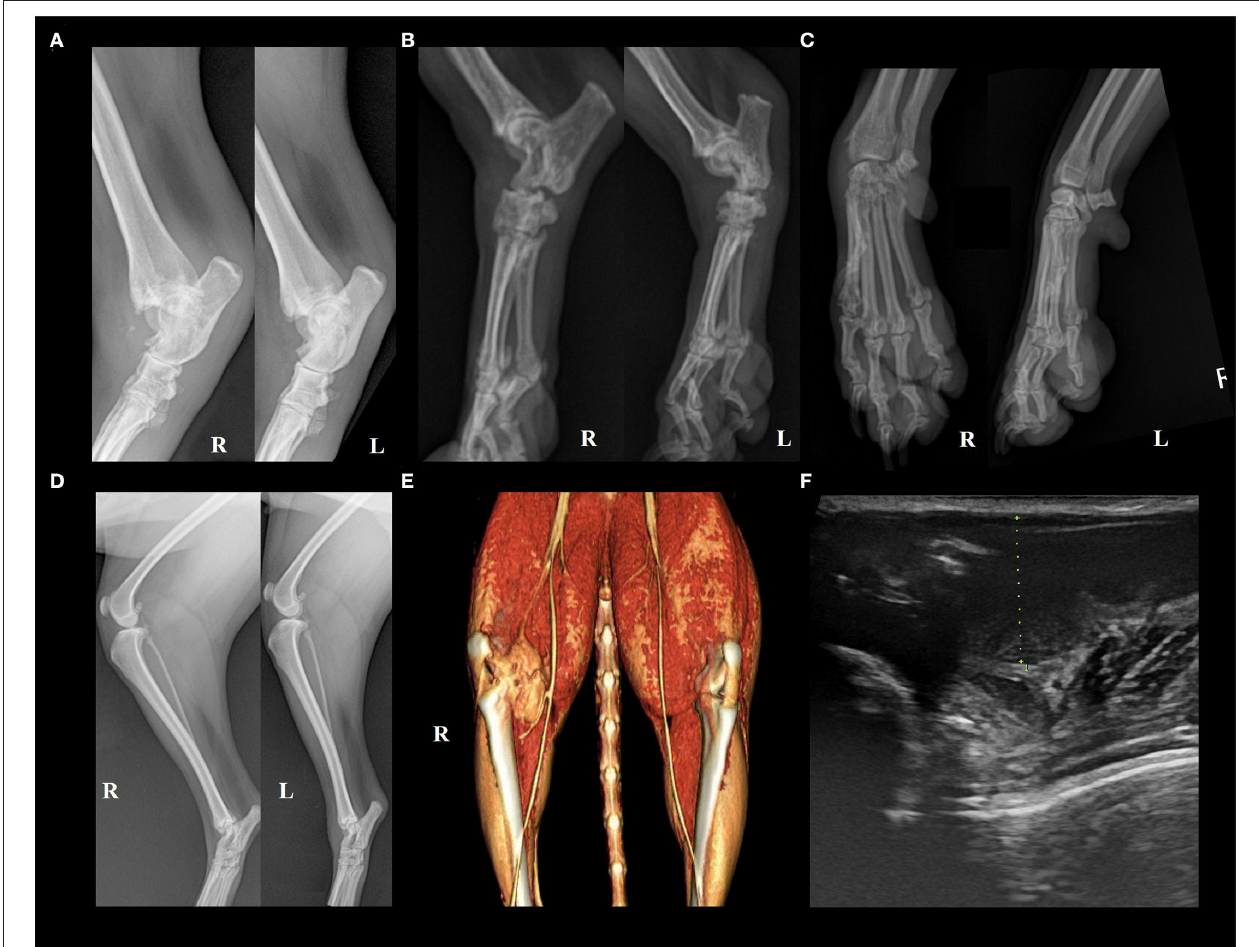
FIGURE 1 | Appearance of articular gout on radiology. (A) Case 1. Erosive changes were seen in the right distal tibia and fibula, 4th tarsal bone, and bilateral talus. The right side limb appeared to be more severely damaged. (B) Case 3. Erosive changes and periosteal reactions were seen in the calcaneus, talus, and tarsal bones in bilateral tarsal joints. Overall, the bones composing the hind limb showed reduced opacity. (C) Case 4. Erosive changes of juxta-articular bones of left carpal joint metacarpal bone, and phalanges. Left oblique (left) and right oblique (right) views. (D) Case 2. Increased soft tissue opacity and thickness on the left tarsal joint region, and right infrapatellar fat pad region, compared to the contralateral side. (E) Case 5. 3D rendered computed tomography image showed an irregular cystic mass continuous with the right stifle joint. (F) Case 5. Ultrasonographic image of the cyst. Green dots indicate cystic structure, and two hyperechoic lines can be seen at the bottom of the image, mimicking the double-contour sign. Echogenic materials can be seen in the articular